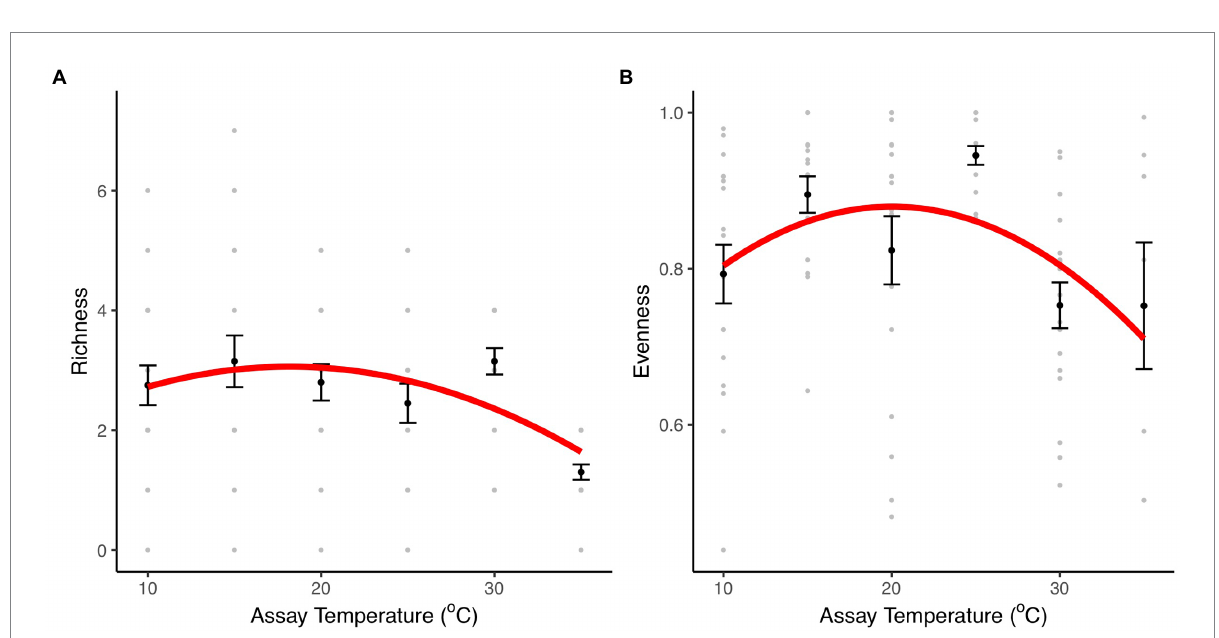
FIGURE 3 Diversity and richness indices. Species evenness and richness indices for communities comprising eight bacterial taxa incubated at 10, 15, 20, 25, 30, and 35 ° C. (A) Taxon richness for community cultures at each temperature treatment. (B) Taxon evenness for communities at each temperature treatment. The black dots and the error bars represent the mean and the SEM. The gray dots are the values obtained in each of the 20 community replicates. The red line represents the fit of a unimodal model (see details of model selection in Supplementary Table S3).